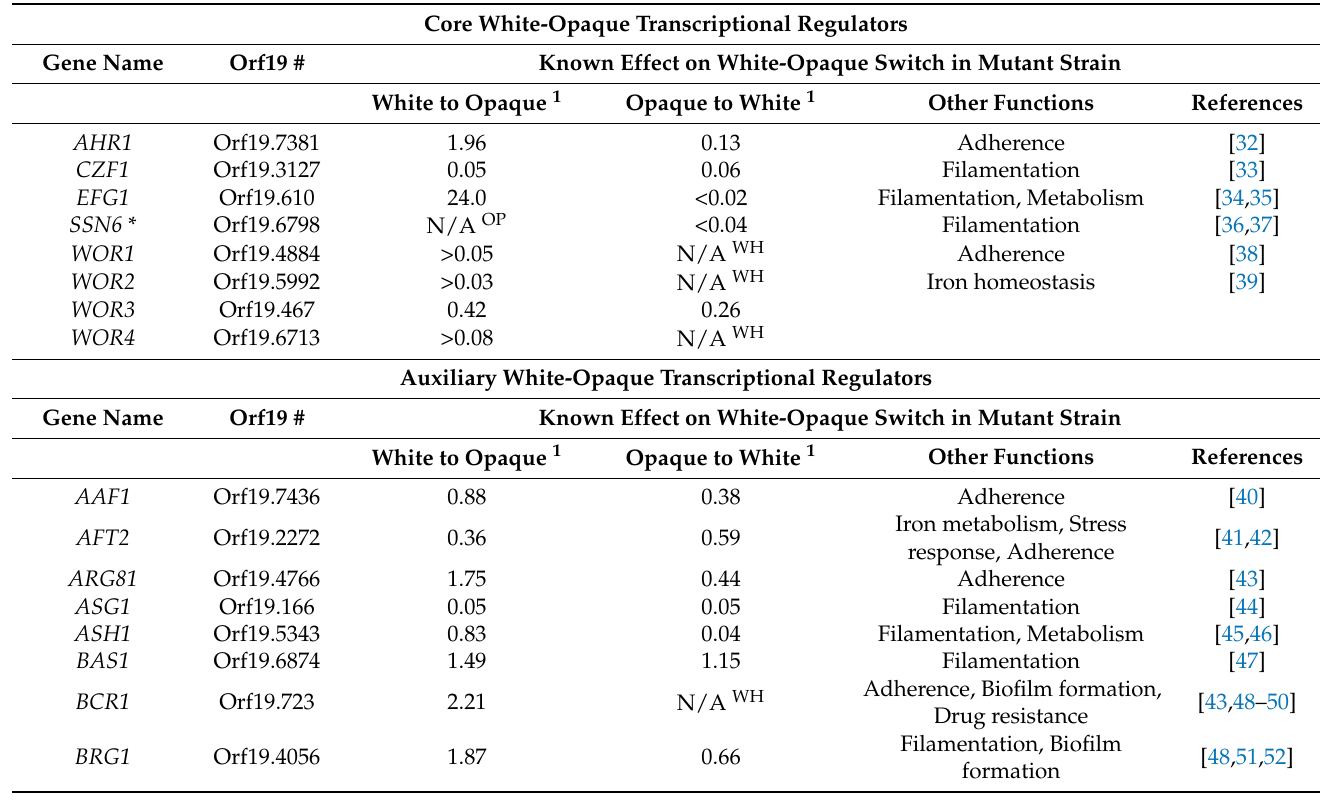
Figure 1. Core white and opaque transcriptional circuits. Colored lines indicate direct binding interactions between each TF (same color as their circular node) and their respective target genes within the white ( A ) and opaque ( B ) circuits. Data to create this figure was obtained from [4,9,22,23,25,27]. Figure was generated using Cytoscape [31]. Table 1. Genes encoding known or predicted TFs and a non-DNA-binding adapter protein with roles in white-opaque switching.